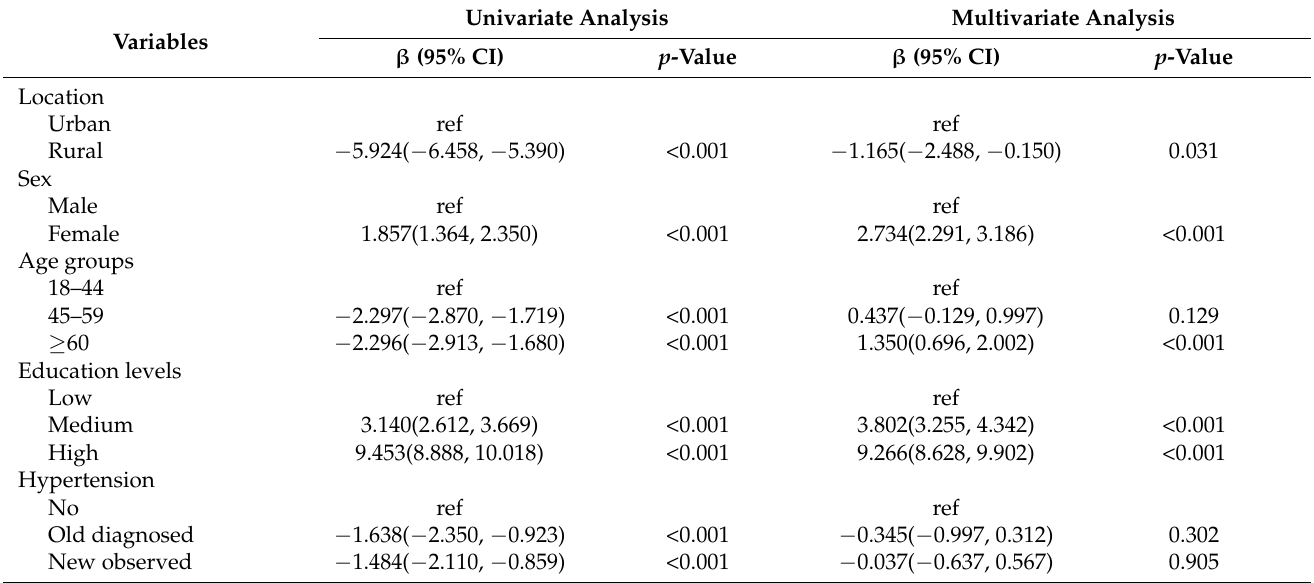
Table 4. Univariate and multivariate analysis (regression coefficient and p -value) of salt-related KAB scores.